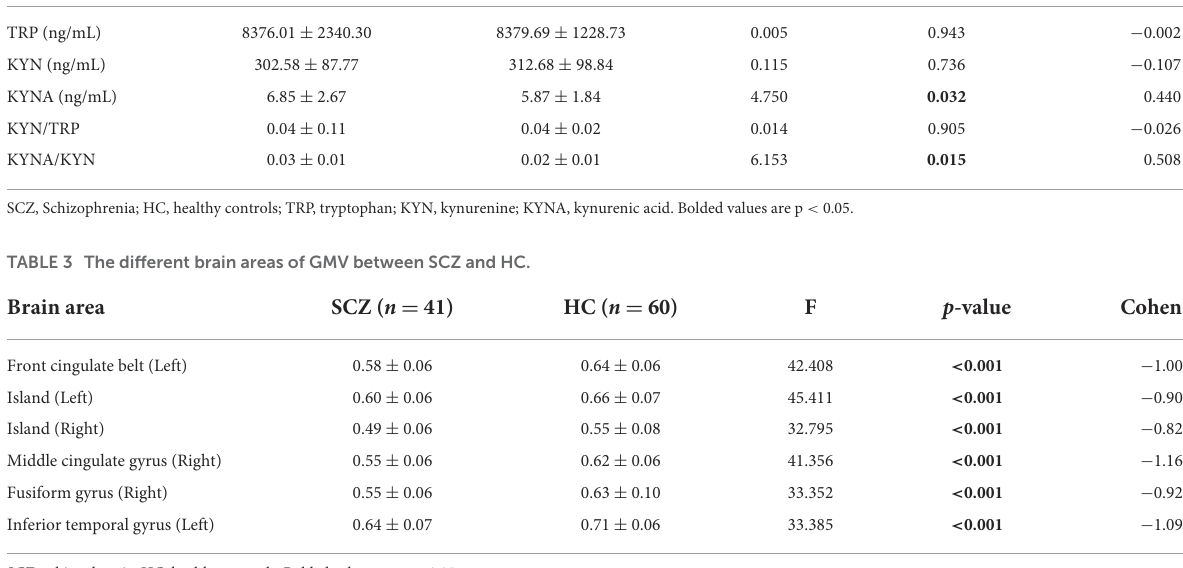
using covariance, and the gray matter volumes in the left anterior cingulate gyrus, left insula, right insula, right middle cingulate gyrus, right cingulate gyrus, and left inferior temporal gyrus were lower in the SCZ group than in the HC group. After the analysis of covariance and correction for the false discovery rate, there was still a significant difference between the schizophrenia subjects and the healthy controls (all p -values <